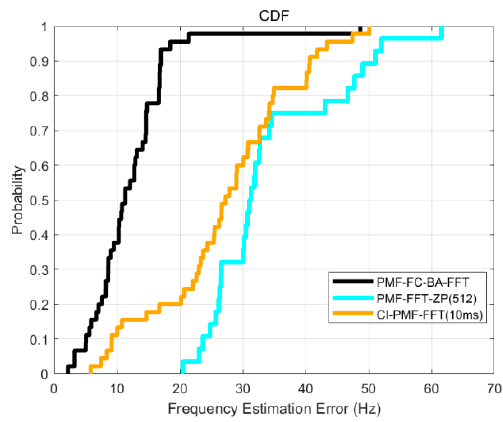
Figure 20. CDF curves of frequency estimation results.